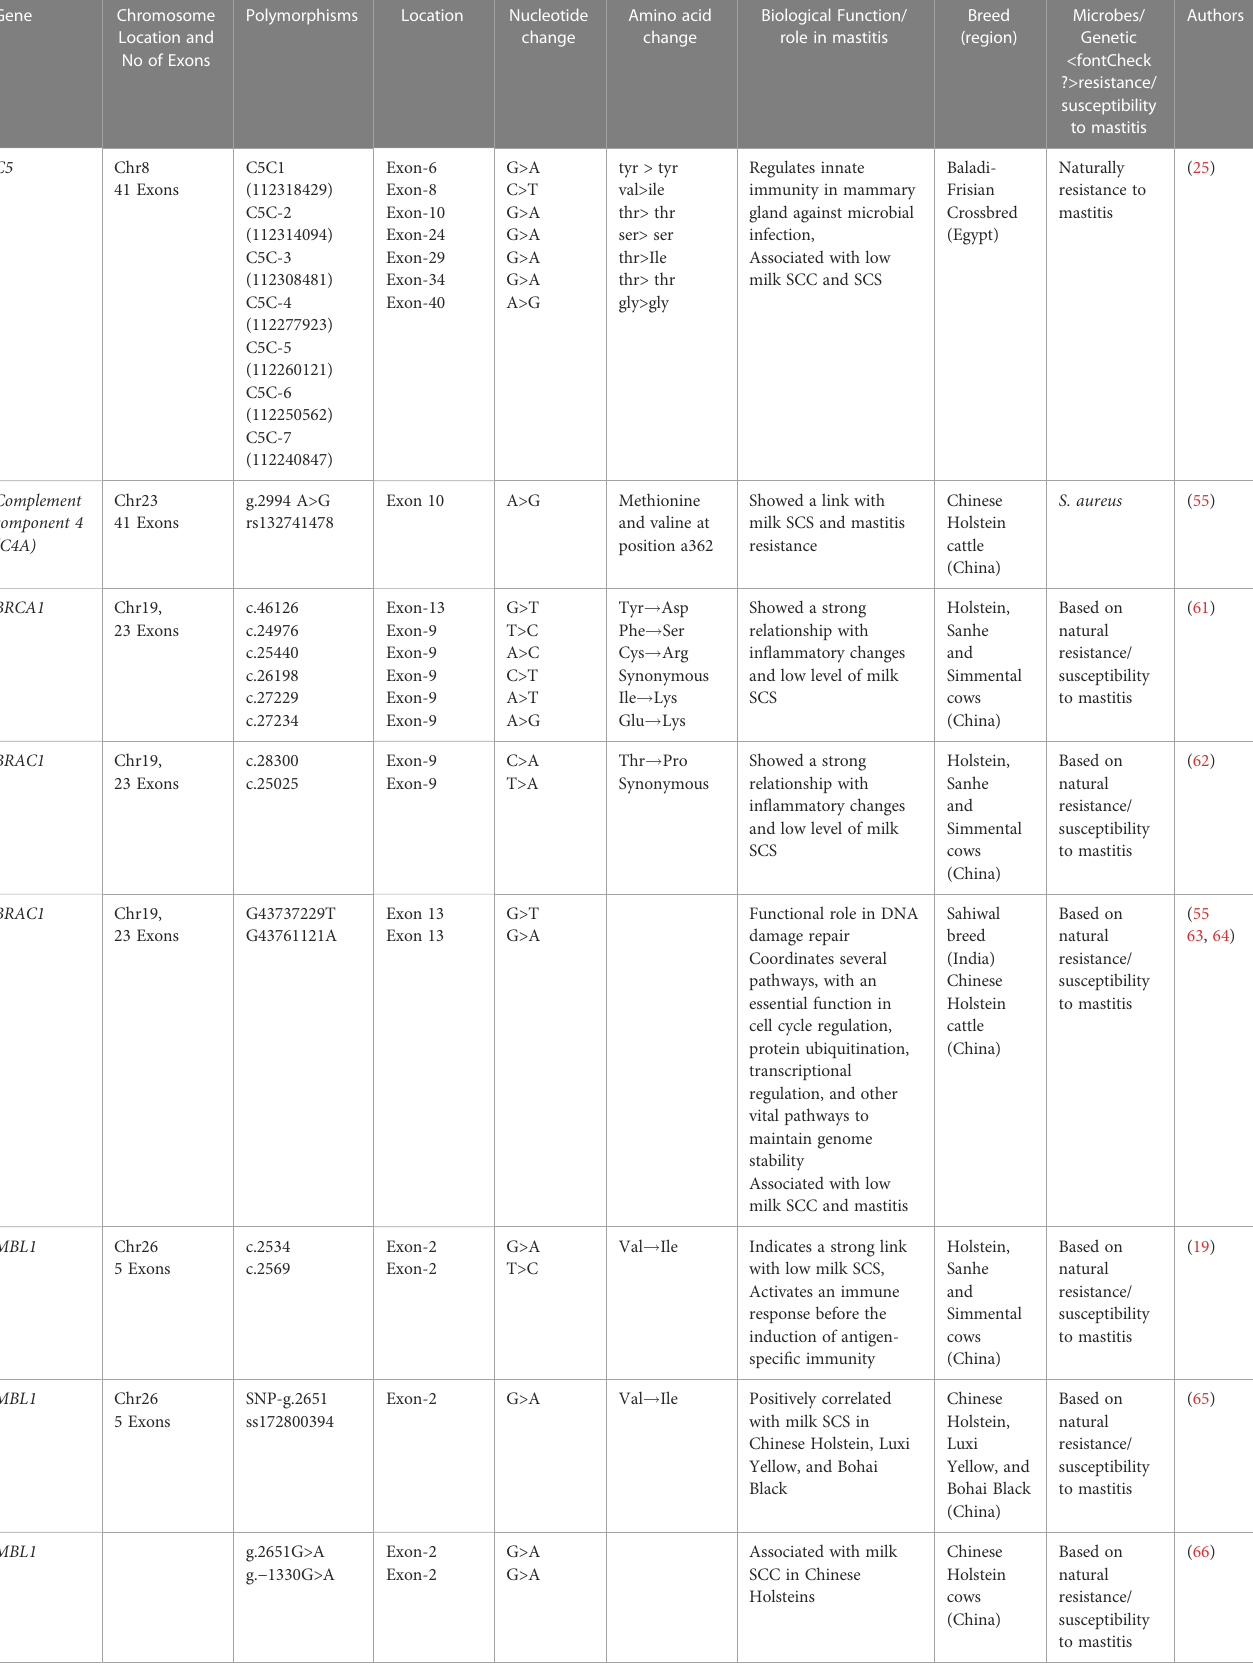
TABLE 1 Polymorphisms in genes associated with bovine mastitis resistance phenotypic